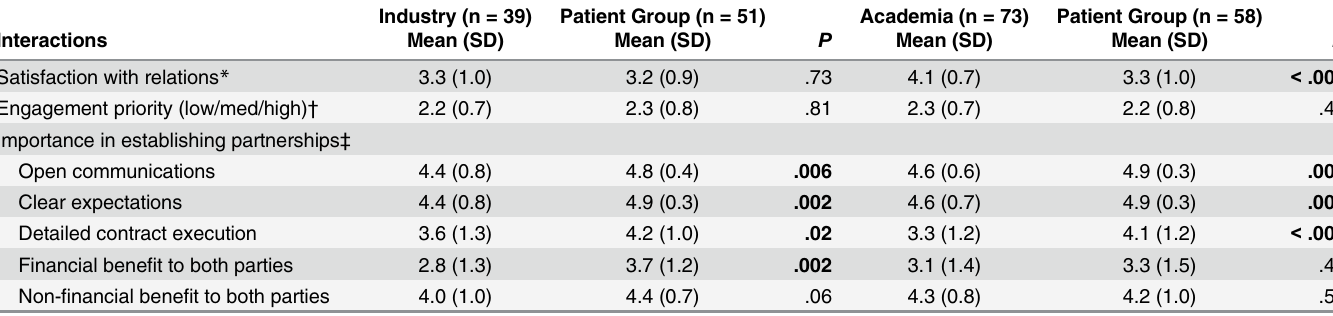
Table 5. Perception of Interactions Between Patient Groups and